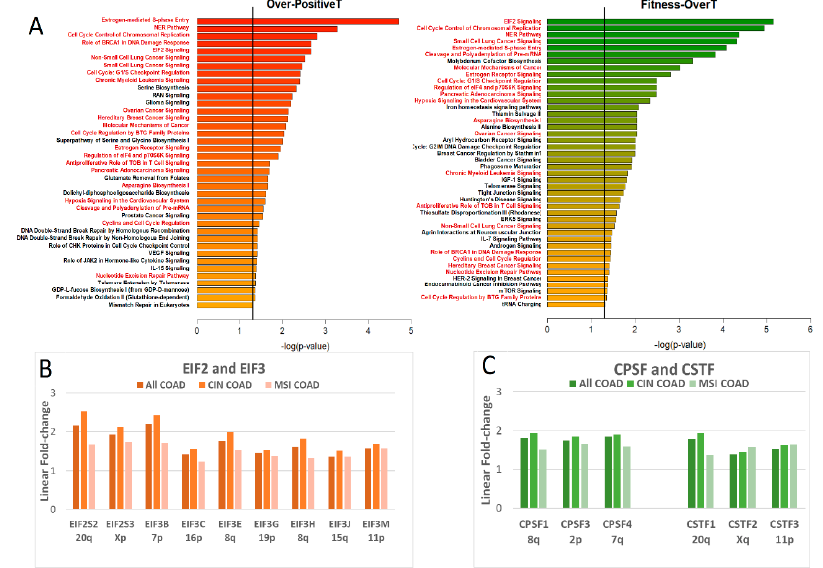
Figure 9. ( A ) The p -values of Canonical pathways significantly associated with Over-PositiveT (left) or Fitness- OverT (right) genes located in 20q, 8q, 13, 7. The vertical black line indicate a p -value equal to 0.05. Canonical pathways shared between Over-PositiveT and Fitness-OverT are written in red letters. ( B ) Expression level of some significantly up-regulated EIF2 and EIF3 genes in COAD samples. ( C ) Expression level of some significantly up-regulated CPSF and CSTF genes in COAD samples. In B and C, the expression level is expressed as linear fold-change in the comparison tumour vs. normal. Only genes significantly up-regulated (linear fold change > 1.5 and False Discovery Rate (FDR) p -value < 0.05 in all COAD samples) are reported. Average values of 433 COAD samples, 223 CIN Coad and 60 MSI COAD are